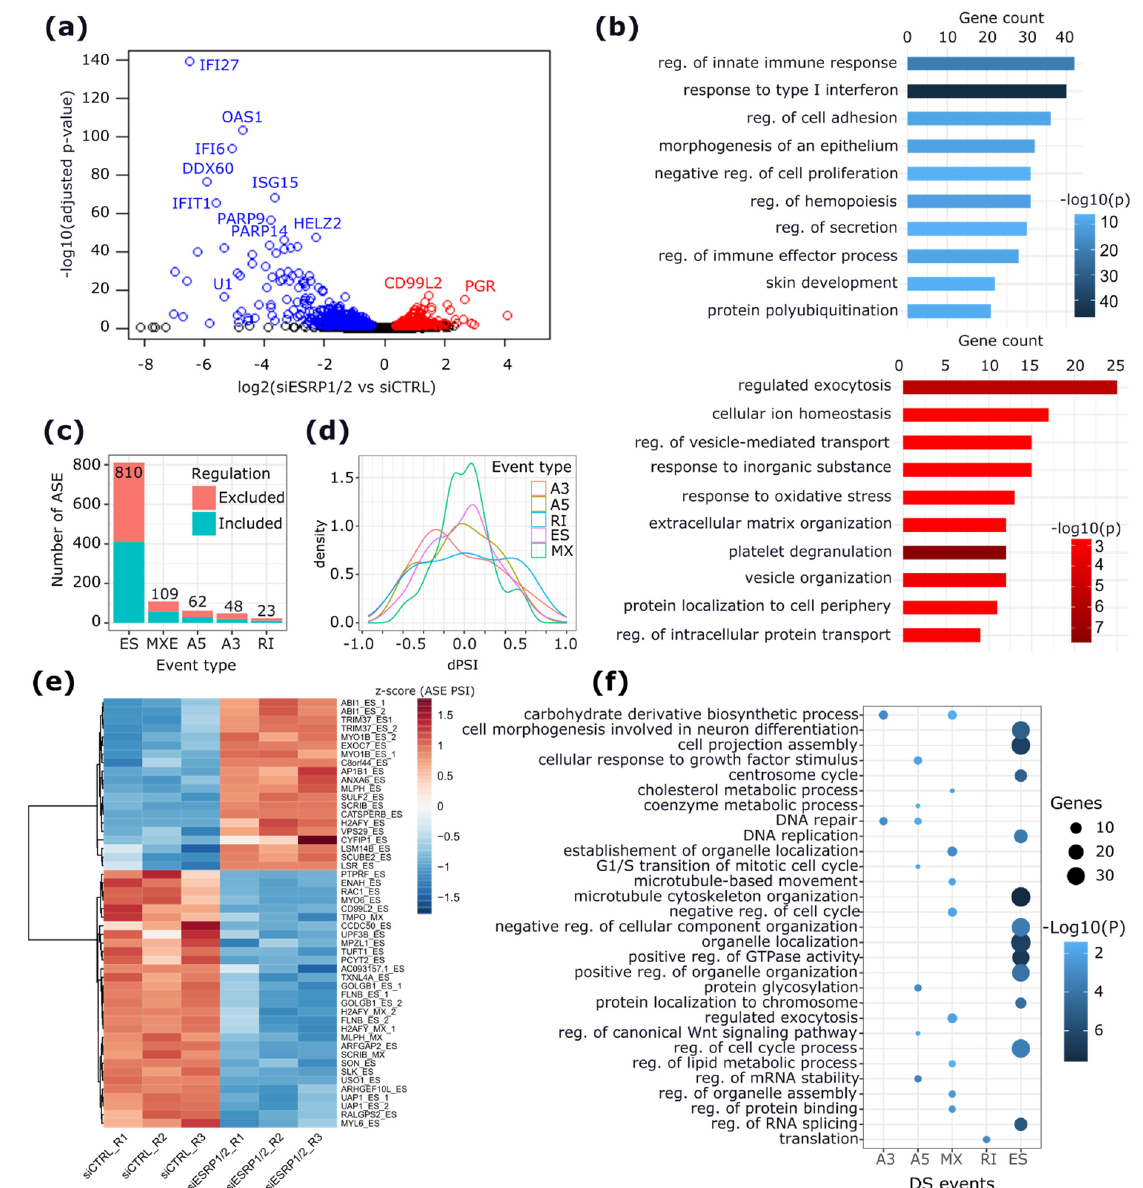
Figure 2. The effects of ESRP1/2 silencing on the transcriptional activity in MCF-7 BC cells. ( a ) Vol- cano plot reporting the log2FC and significance of downregulated (in blue) and upregulated (in red) DE genes. Labels are provided for the top significant DE genes. ( b ) Bar plots showing the gene counts and the significance of gene ontology (GO) terms enriched for downregulated (blue) and upregulated (red) DE genes. ( c ) Bar plot showing the number of significantly changing ASEs compared to control cells. ES—exon skipping; MX—mutually exclusive exons; A5—alternative 5 ′ splice sites; A3—alternative 3 ′ splice sites; RI—retained introns. ( d ) Density plots showing the distribution of delta-PSI (dPSI) of each event type. ( e ) Heatmap of PSI values of the top 50 significant differential ASEs regulated by ESRP1/2 knock-down. The labels provided are the symbols of genes harboring significant ASEs. ( f ) Dot plots showing the GO terms enriched for genes harboring significant ASEs. The size of the dots is proportional to the gene count and the color intensity is proportional to the enrichment significance.